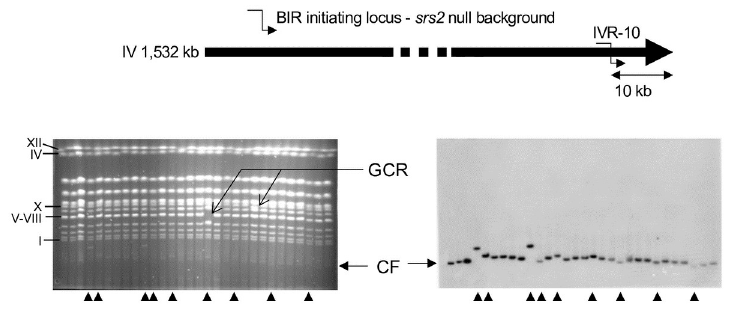
Fig 7. PFGE and Southern blot of BIR products initiated at the IVR-10 locus in the absence of Srs2. Ethidium bromide stained gels (left) and corresponding radioactive signal from Southern blot using a URA3 probe specific of the chromosome fragmentation vector (right) are shown. Arrowheads indicate chromosome fragments (CF) of abnormal size resulting from BIR initiated by the chromosome fragmentation vector. Gross chromosomal rearrangements (GCR) are indicated by arrows. Roman numbers on the left correspond to S . cerevisiae chromosome numbers.